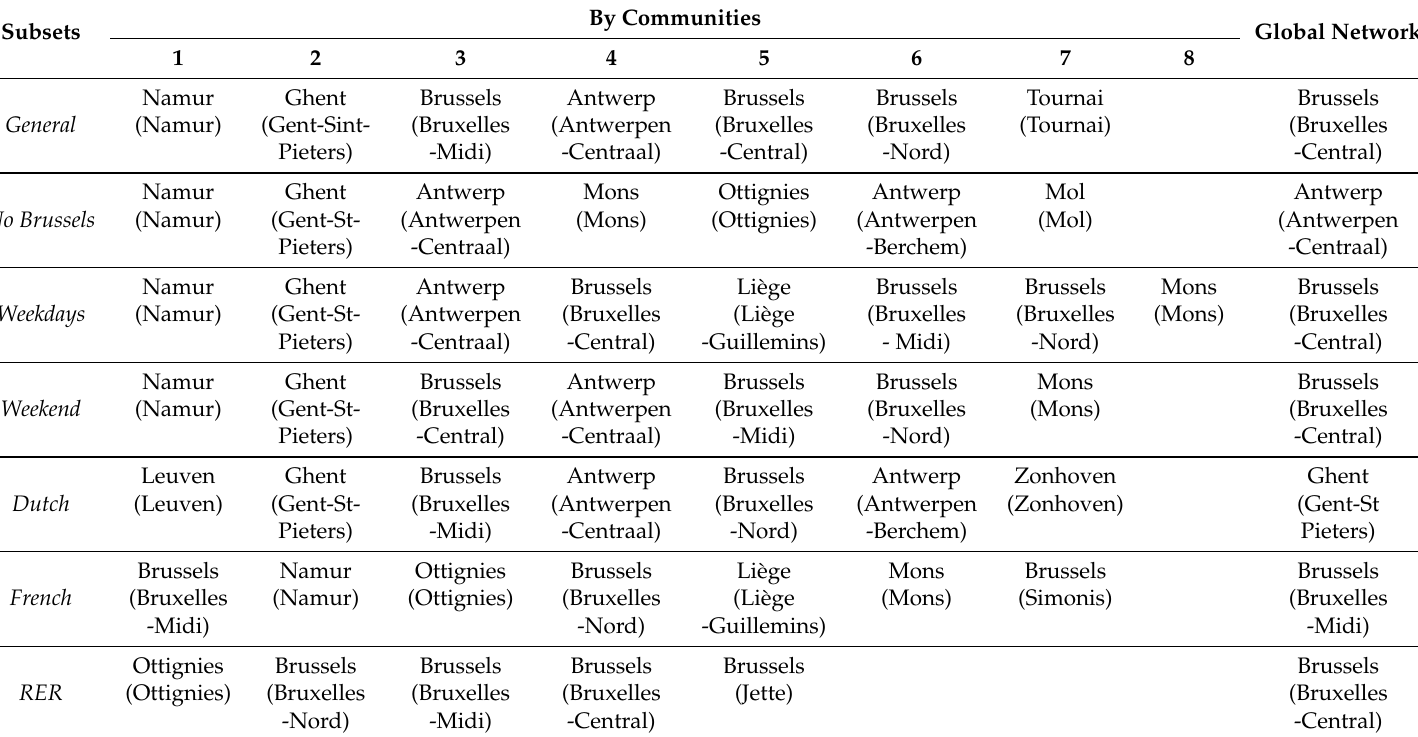
Table A1. Central node of the communities by betweenness centrality (between brackets = name of the train station). Subsets